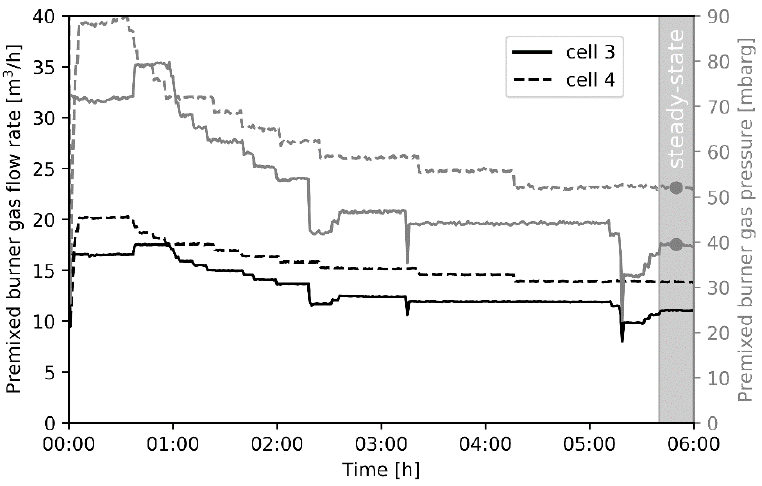
Figure 10. Premixed burner gas flow rate to cell 3 (dashed line) and cell 4 (full line) individually (left) and premixed burner gas pressure (right) for the first uncoated experiment (uncoated 1).